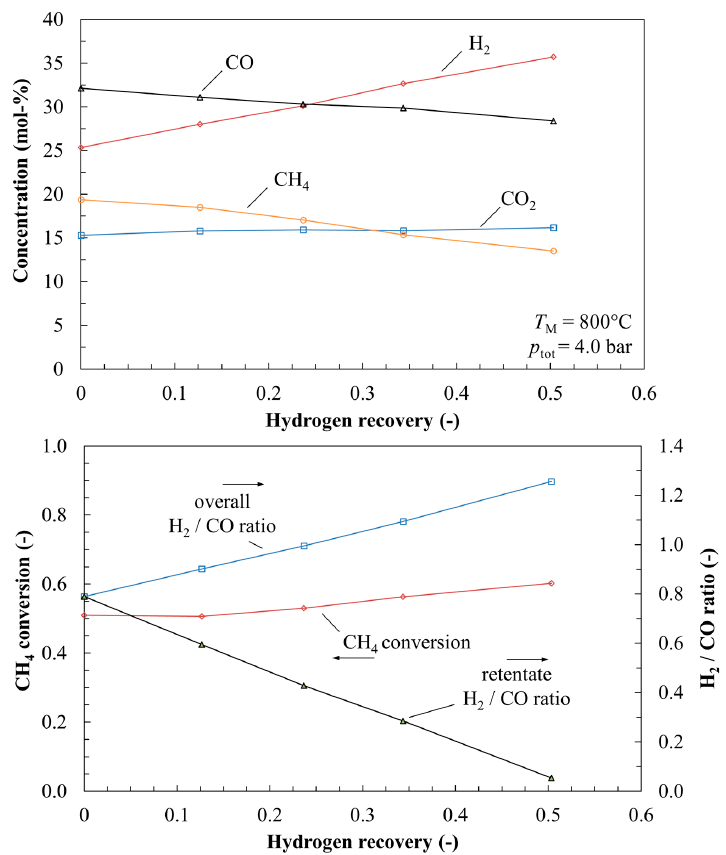
Figure 5. Influence of hydrogen separation on gas composition, CH 4 conversion and H 2 /CO ratio at reference point: 150 L min − 1 CO 2 , 150 L min − 1 CH 4 , membrane temperature: 800 ◦ C, system pressure 4.0